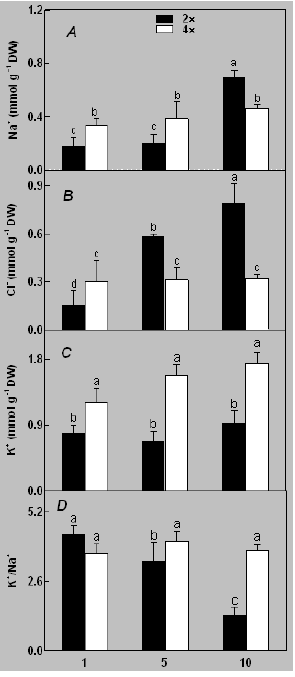
Figure 4. Effects of salt stress on the concentrations of Na + ( A ), Cl − ( B ), K + ( C ), and the K + /Na + ratio ( D ) in the leaves of Robinia pseudoacacia diploid (2×) (black bars) and tetraploid (4×) (white bars) plants growing after salt treatment. Values followed by different letters are significantly different from each other at p < 0 . 05 according to Duncan’s method. Each data point represents the mean ± standard error of three replicates.